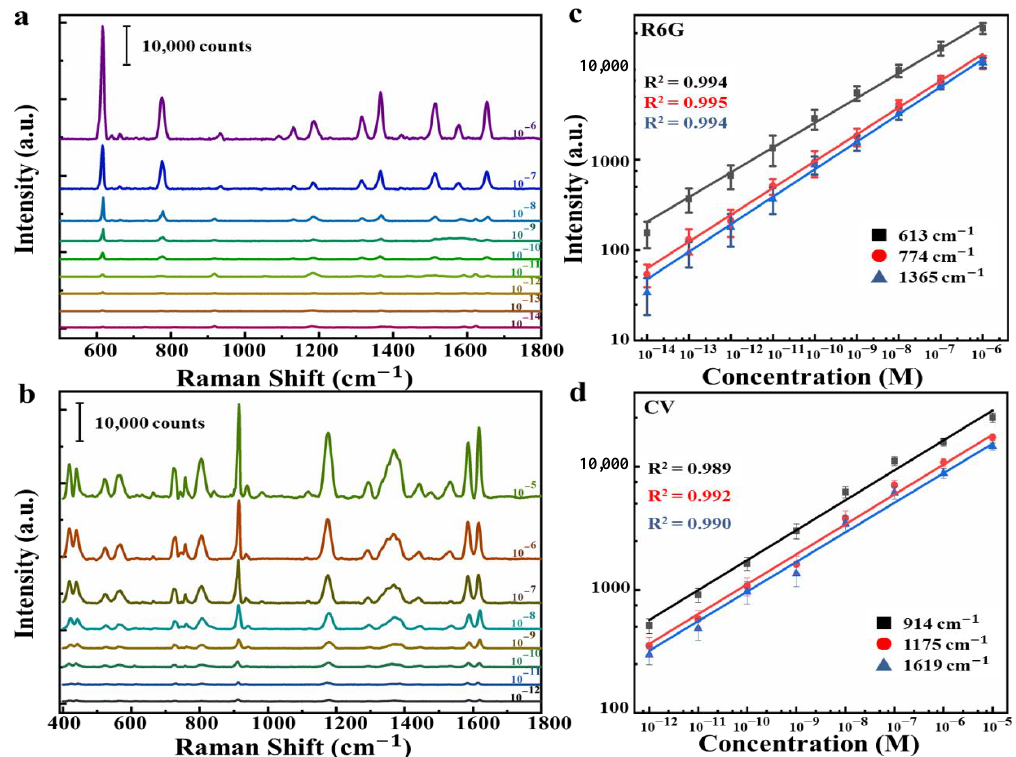
Figure 5. Raman spectra of ( a ) R6G and ( b ) CV on multilayer substrate with four CM − EM units from 10 − 14 M to 10 − 6 M and from 10 − 12 M to 10 − 5 M, respectively. The Raman signal intensity of ( c ) R6G at 613, 774, and 1365 cm − 1 peak, and ( d ) CV at 914, 1175, and 1619 cm − 1 peak as a function of molecular concentration in the log–log